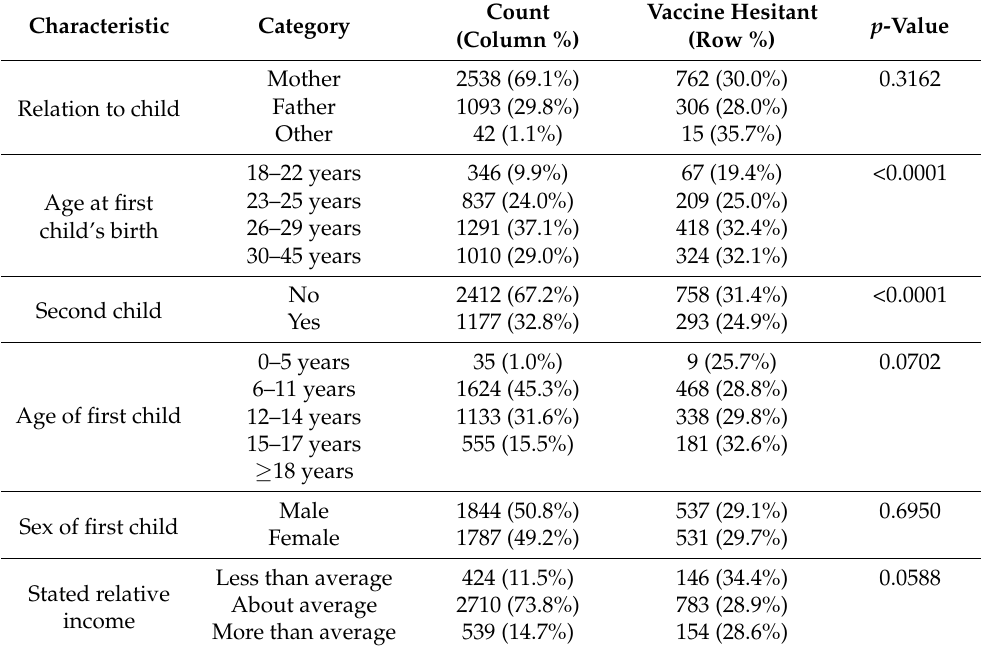
Table 1. Demographic characteristics of a sample of Shanghai parents of school-aged children, 2020.